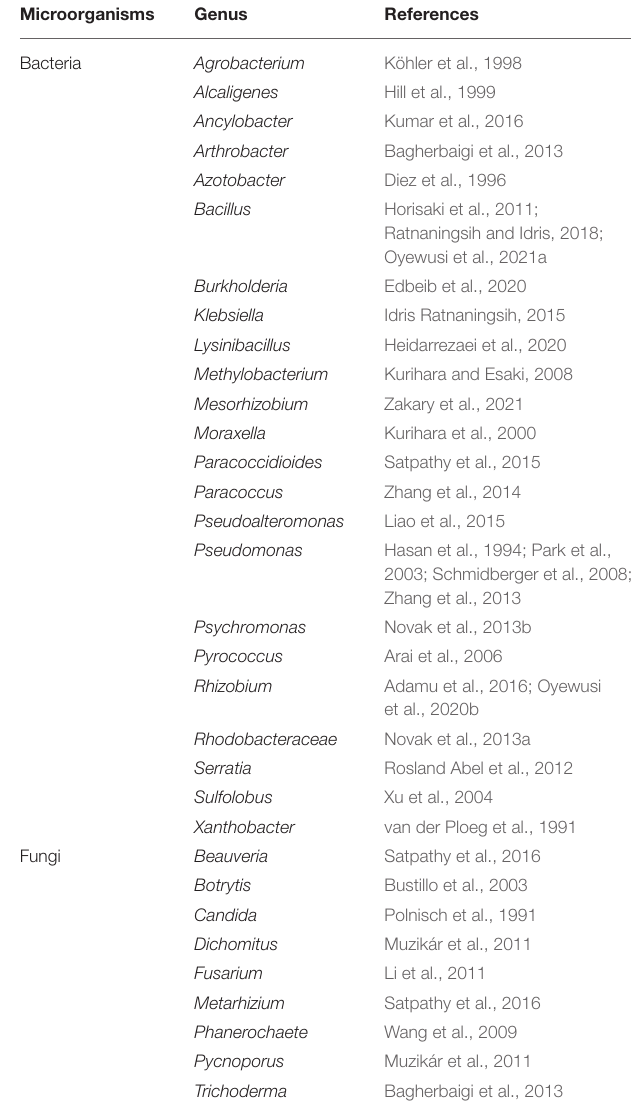
TABLE 1 | The reported microorganisms degrading 2-haloalkanoic